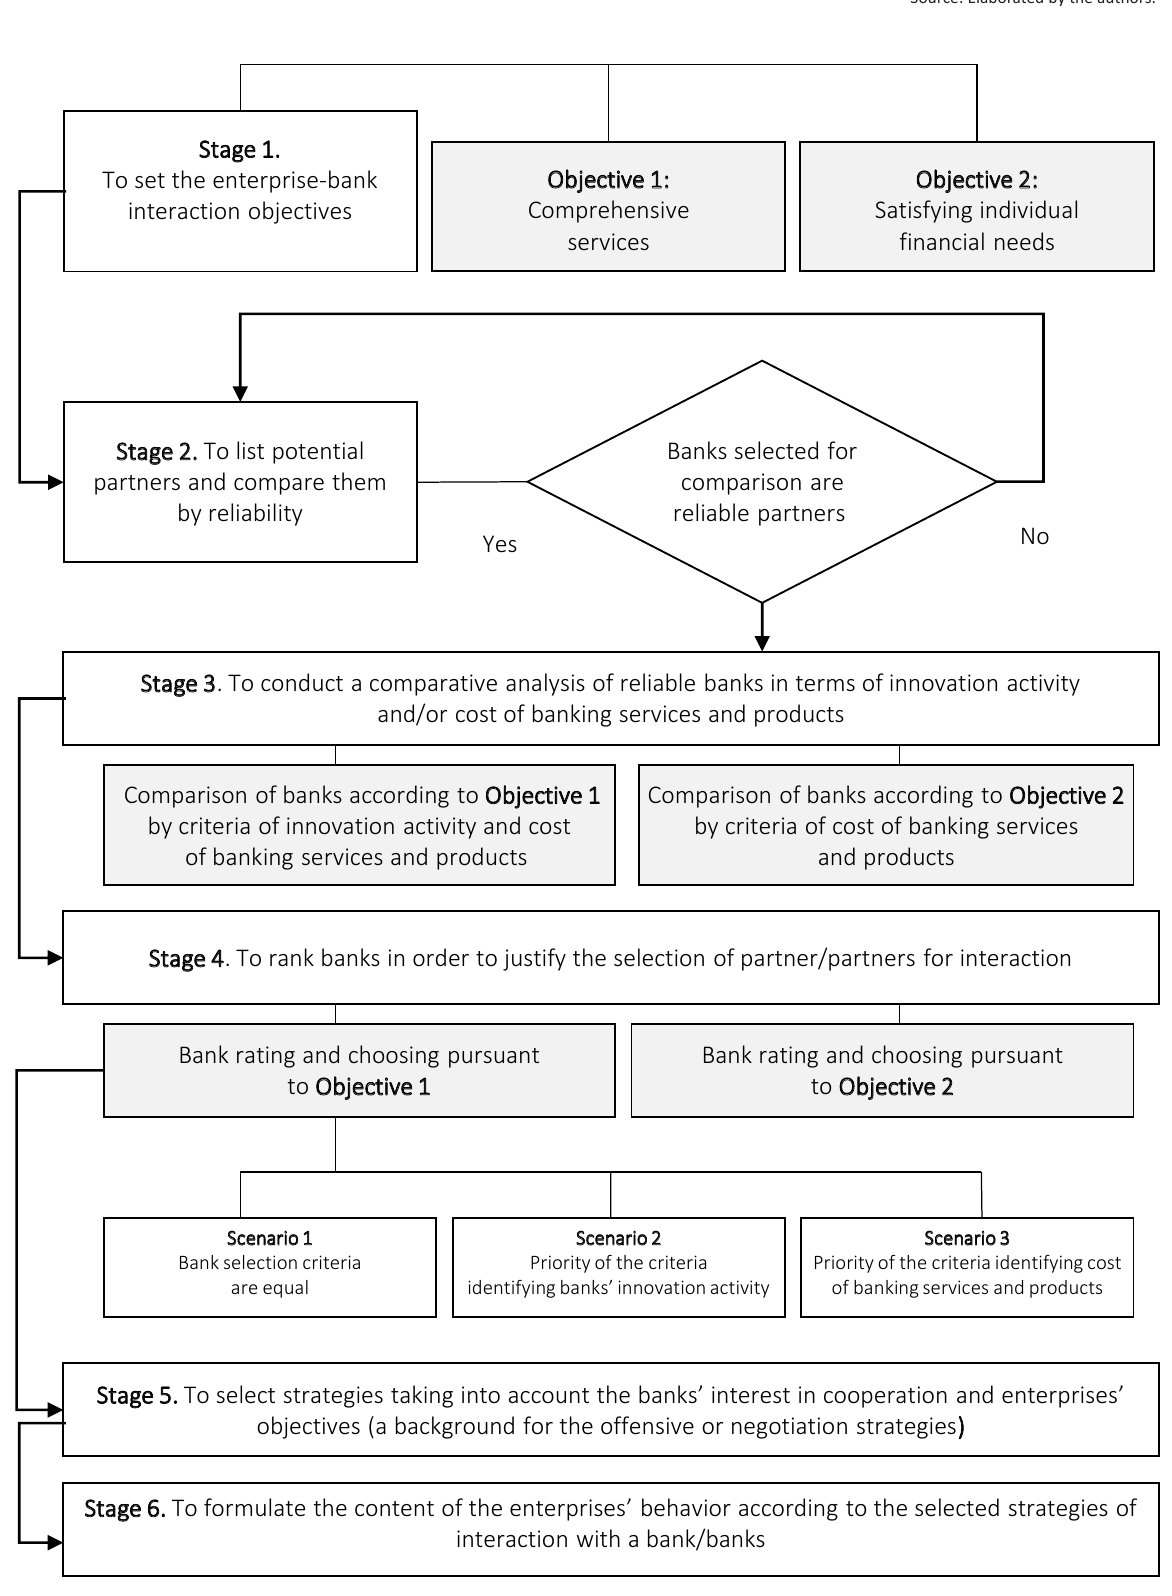
Figure 1. Stages of selecting the enterprise-bank interaction strategies considering the stakeholders’